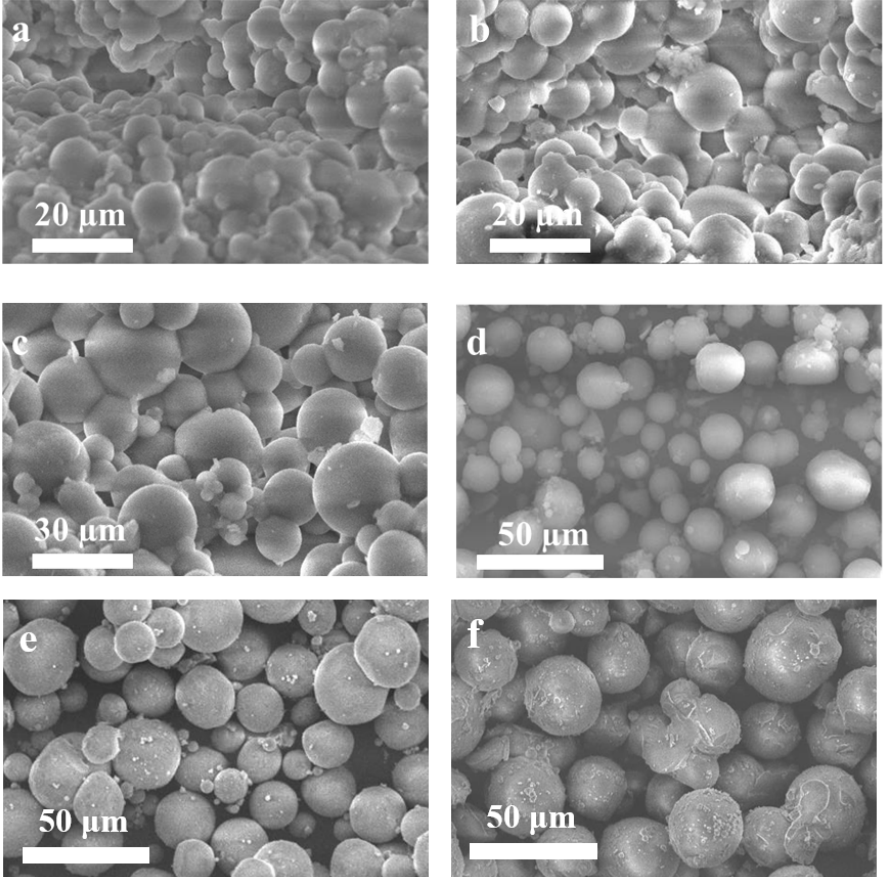
Figure 2. SEM images of pure silica aerogel spheres of wg-SAMS-4.5 ( a ), wg-SAMS-3.5 ( b ), wg-SAMS-2.5 ( c ), teos-SAMS-4.5 ( d ), teos-SAMS-3.5 ( e ), and teos-SAMS-2.5 ( f ). N 2 adsorption–desorption isotherms of the SiO 2 aerogel microspheres are shown in Figure S6. The isotherms for SAMS display type IV isotherms with H1 hysteresis loops.